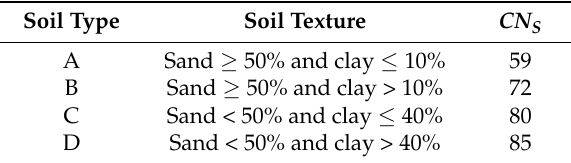
Table 2. Soil texture classification and values of soil curve number ( CN S ) in AMC-I. Soil Type Soil Texture CN S Sand ≥ 50% and clay ≤